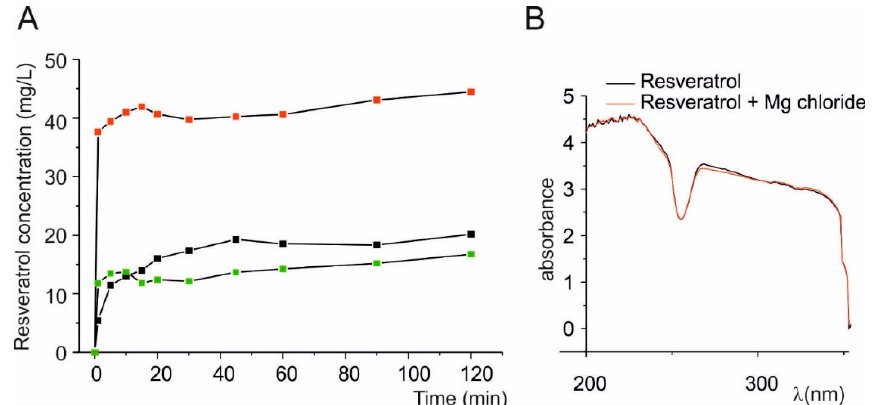
Figure 4. Solubility of resveratrol from Resv@MDH and its interaction with magnesium ion. ( A ) dissolution test of pure resveratrol powder (black MDH square) versus solid dispersion on magnesium dihydroxide (Resv@MDH, red square) and pure micronized resveratrol (green square). ( B ) UV/Vis Absorbance spectroscopy for the study of Resveratrol. Black: 0.008 mM Resveratrol in ethanol:water (75:25, v / v ) in 100 mM HCl; Red: 0.008 mM Resveratrol in ethanol:water (75:25, v / v ) in 100 mM HCl + 0.008 mM of MgCl.